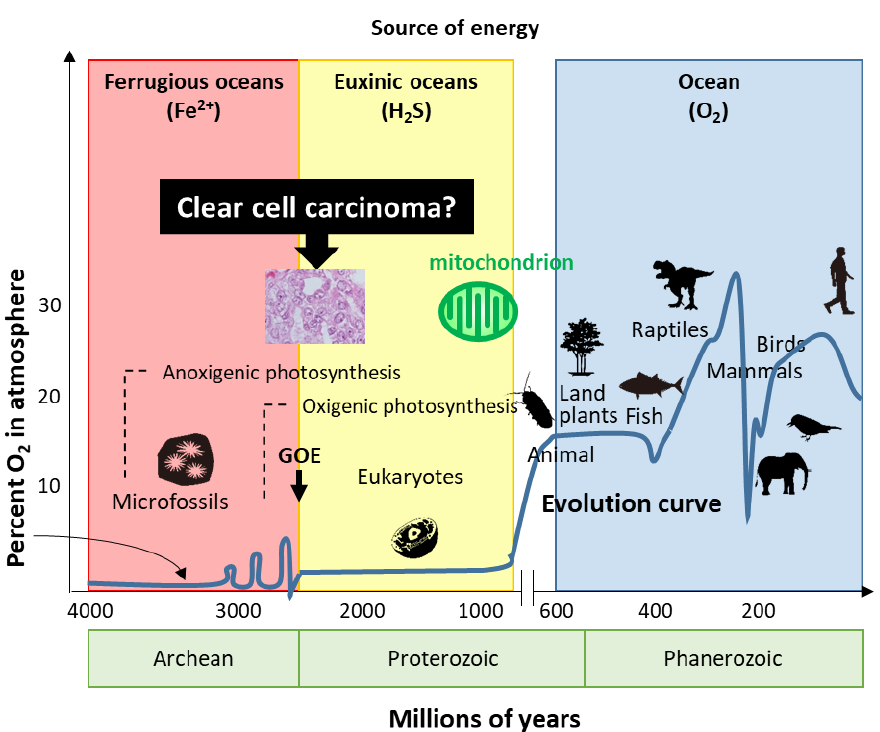
Figure 3. Evolution of life. Based on energy production, ovarian clear cell carcinoma seems to show evolution or reversion because of traditional energy metabolism. GOE: great oxidation event.